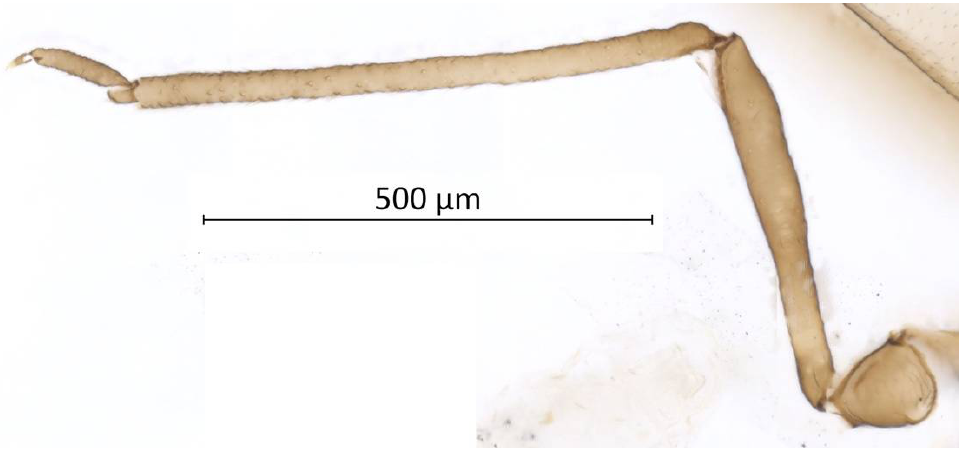
Figure 6. Mesosternal furca of alate vivipara of Qiao jinshaensis sp. nov. (QMOR66202).